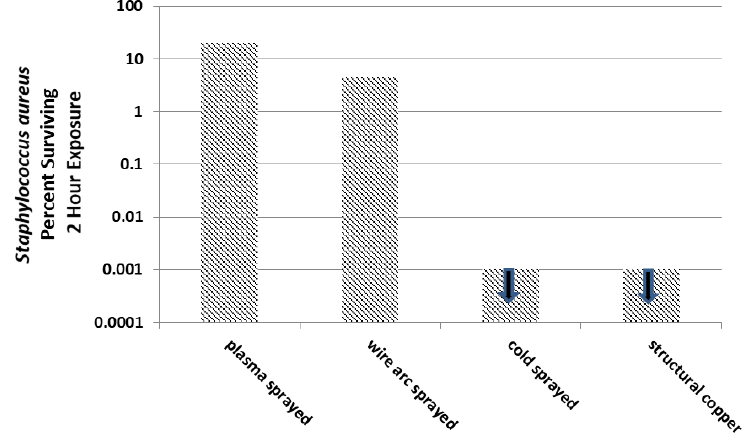
Figure 4. Percent methicillin-resistant Staphylococcus aureus (MRSA) surviving after a two-hour exposure to copper surfaces.